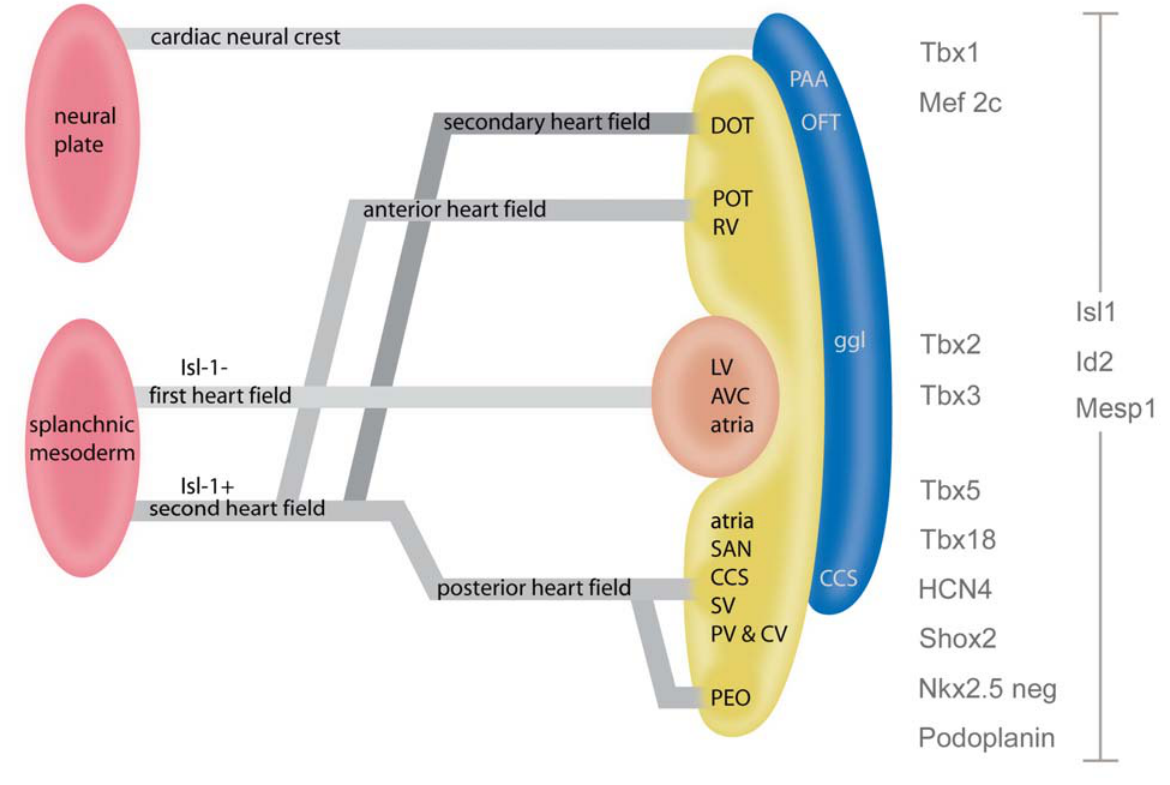
FIGURE 3. Schematic representation of the primary heart tube (brown) and the secondary added myocardium derived from the second heart field (yellow), including differential genes and proteins expressed in the second heart field. The second heart field can be divided into an anterior heart field and a secondary heart field at the anterior pole of the heart, and a posterior heart field at the venous pole of the heart. At the venous pole of the heart, the proepicardial organ (PEO) is also derived from the posterior heart field, and is the source of the epicardium and epicardium-derived cells. Neural crest cells (depicted in dark blue) migrate to the heart and enter the heart at both the arterial and venous pole. AVC: atrioventricular canal, CV: cardinal veins, CCS: central conduction system, DOT: distal outflow tract, LV: left ventricle, OFT: outflow tract, PAA: pharyngeal arch arteries, POT: proximal outflow tract, PV: pulmonary veins, RV: right ventricle, SAN: sinoatrial node, SV: sinus